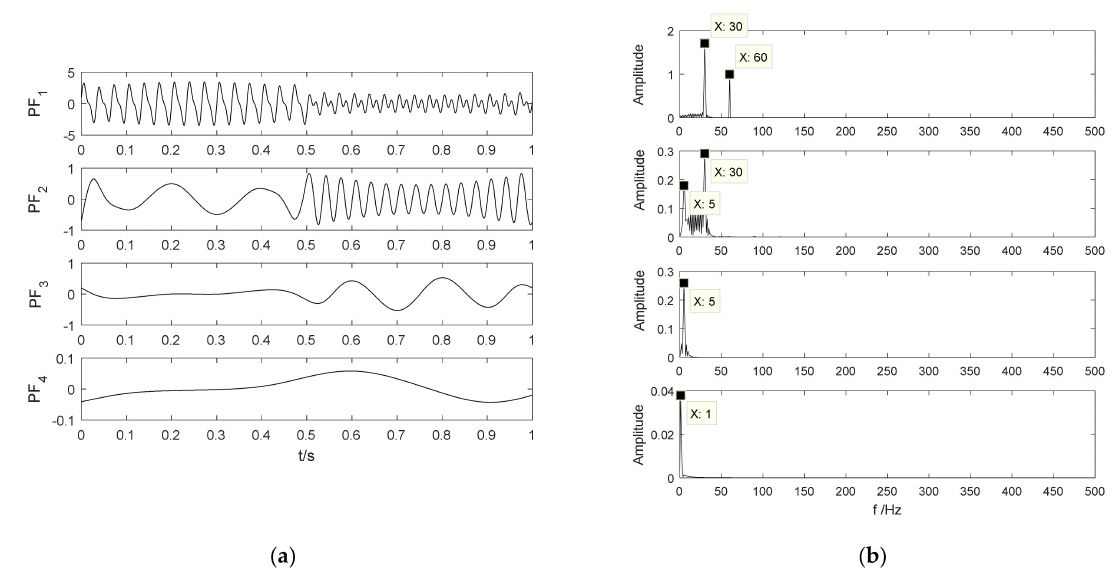
Figure 6. The decomposition results of local mean decomposition (LMD). ( a ) Time domain; ( b ) Frequency domain.